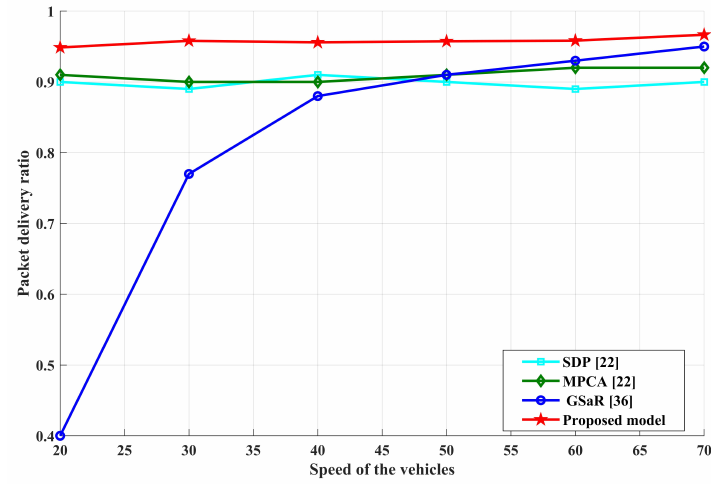
Figure 11. Packet delivery ratio vs. number of vehicles.